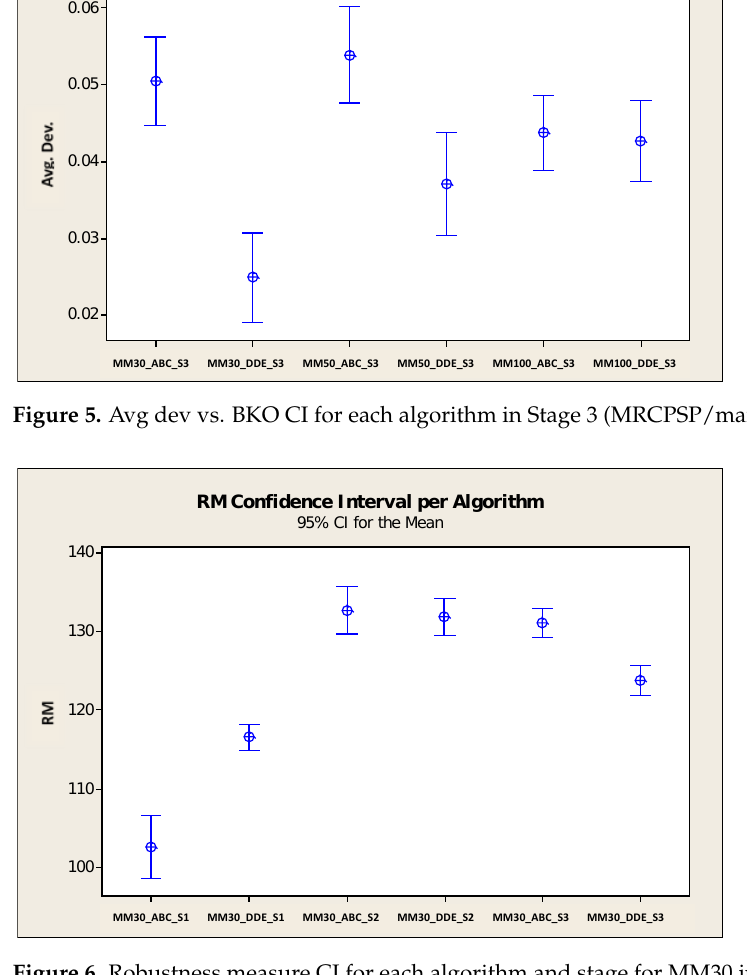
Figure 6. Robustness measure CI for each algorithm and stage for MM30 instances. RM Confidence Interval per Algorithm 95% CI for the Mean